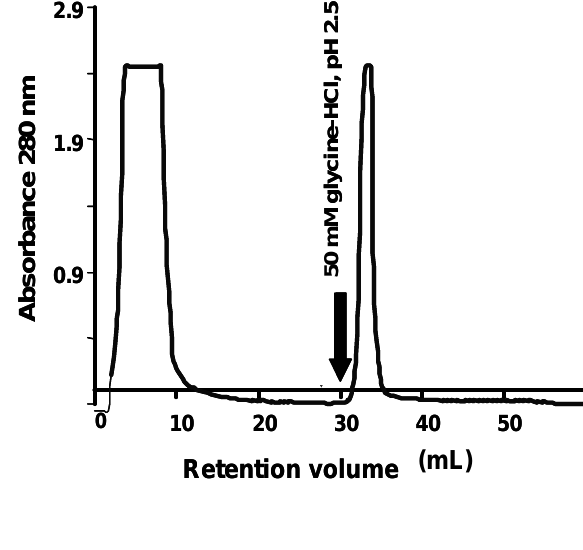
Figure 1. Affinity chromatography in immobilized fetuin of the aqueous extract from tepary beans after precipitation with ammonium sulfate. The lectin fraction was eluted with an acid solution (50 mM glycine-HCl, pH 2.5). The purification yield is shown in Table